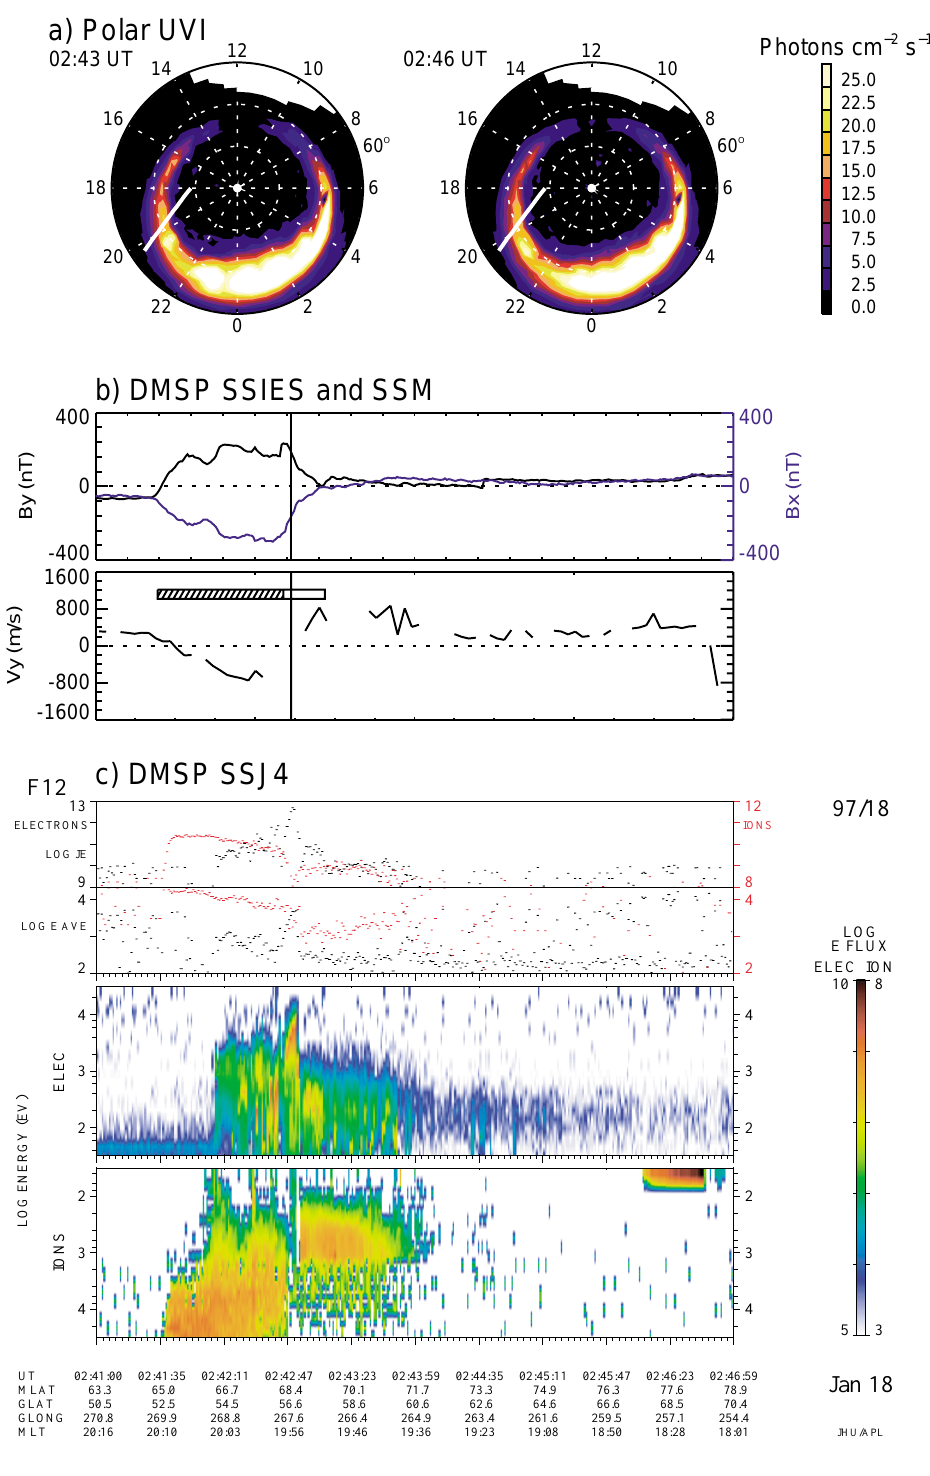
Fig. 5. A summary of observations for the 02:41–02:47 UT, 18 January 1997 event. The format is the same as that for Fig. 2.